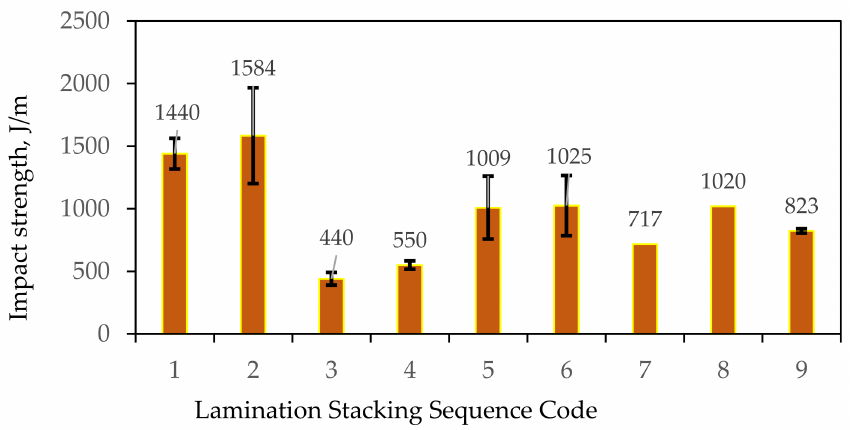
Figure 3. Impact strength of different lamination samples. Note: The numbers 1–9 pertain to lamination stacking sequence code (see Table